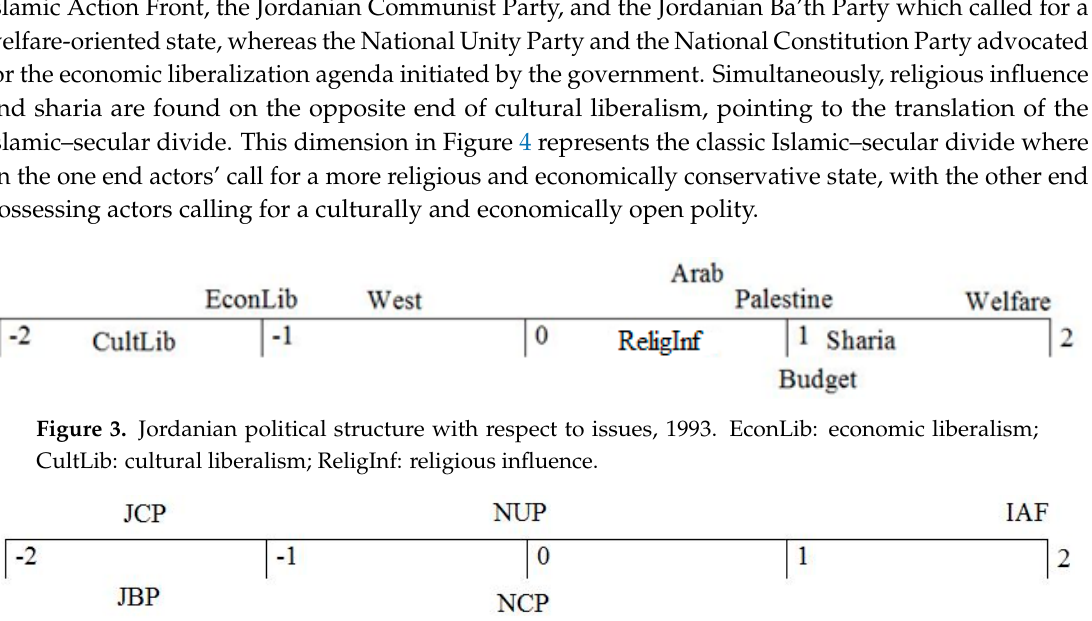
Figure 4. Ideological map for Jordanian parties, 1993. JCP: Jordanian Communist Party; JBP: Jordanian Ba’th Party; NUP: National Union Party; NCP: National Constitution Party; IAF: Islamic Action Front.